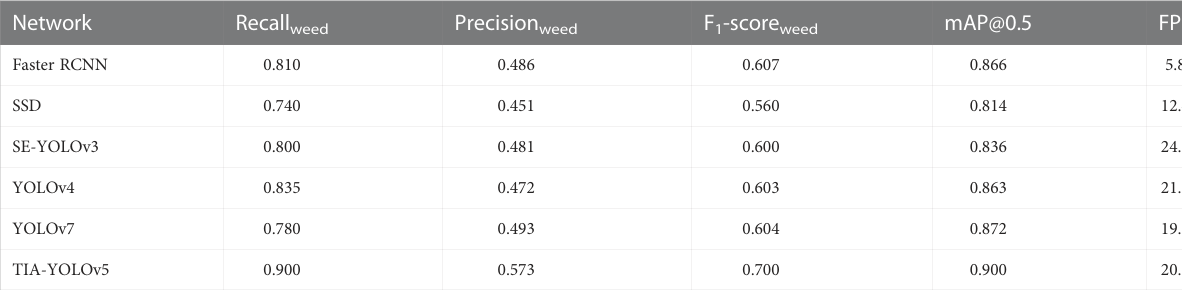
TABLE 2 Performance comparison of fi ve networks for sugarbeet and weed detection.